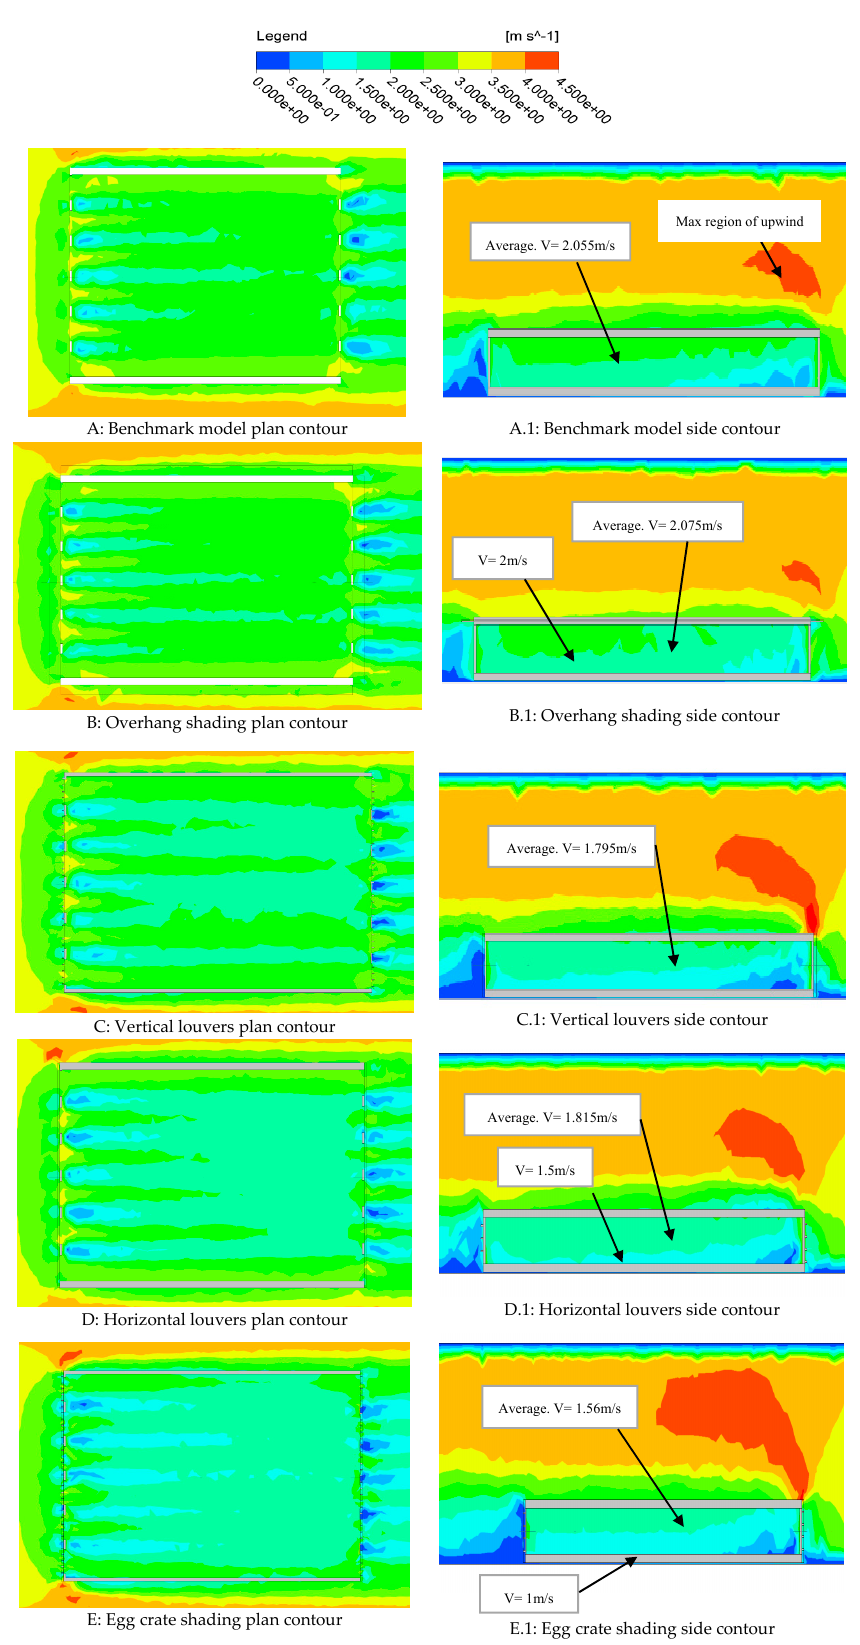
Figure 13. Constant velocity contour levels .